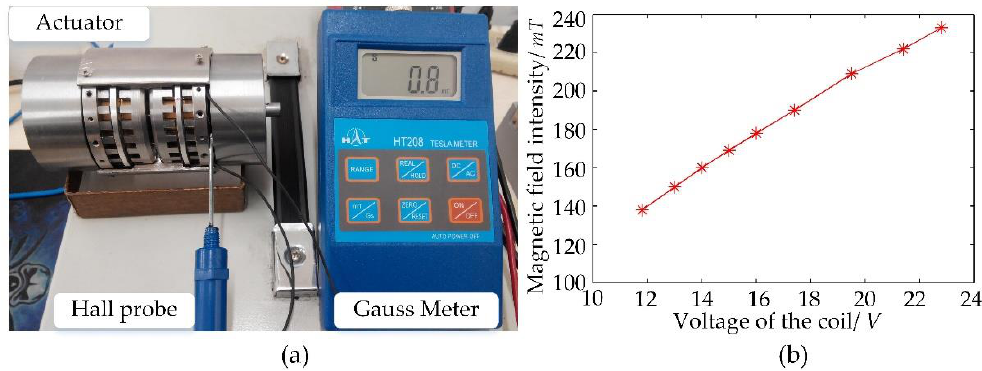
Figure 16. Magnetic field measurement of the actuator: ( a ) Experimental devices; ( b ) Measurement results.